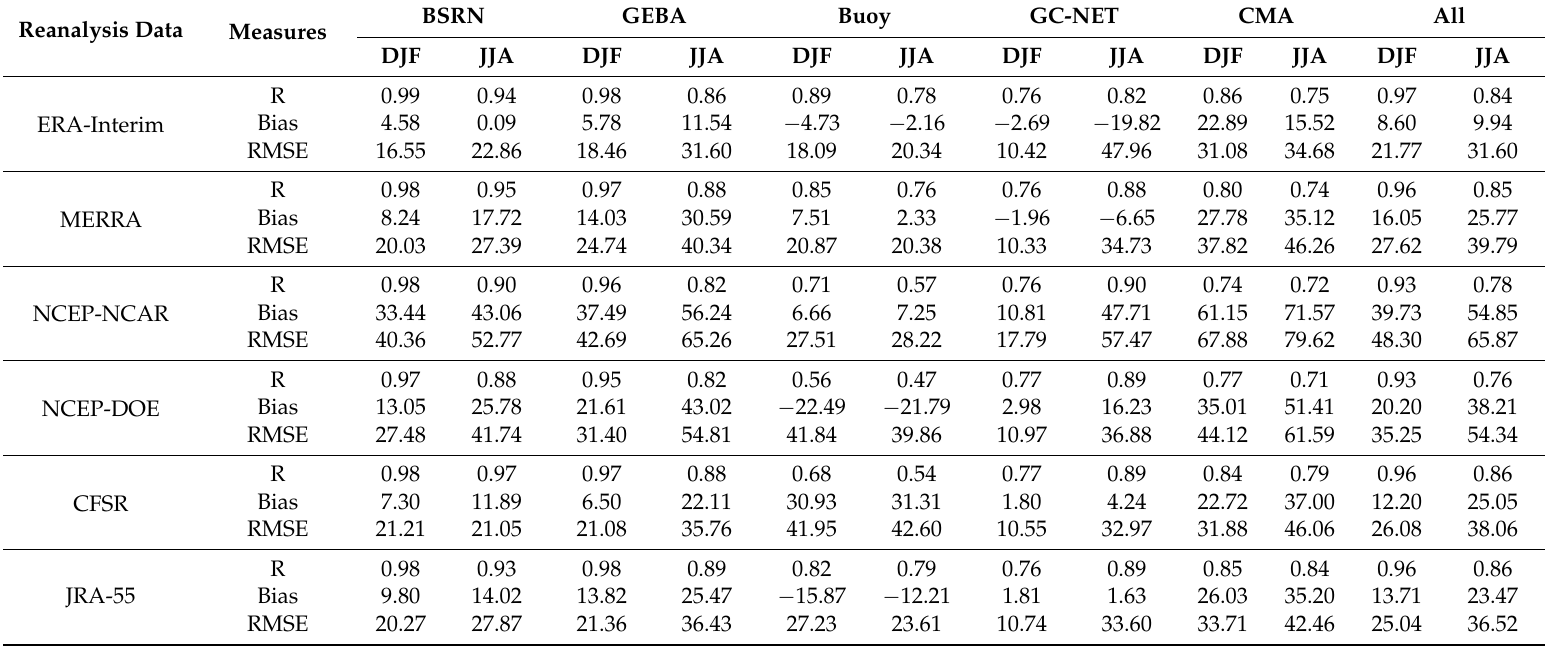
Table 3. Seasonal validation results for the monthly R s of six reanalysis data sets using surface measurements collected from 674 stations from 2001 to 2009. DJF represents December, January, and February, whereas JJA represents June, July, and August. Units are W/m 2 for bias and